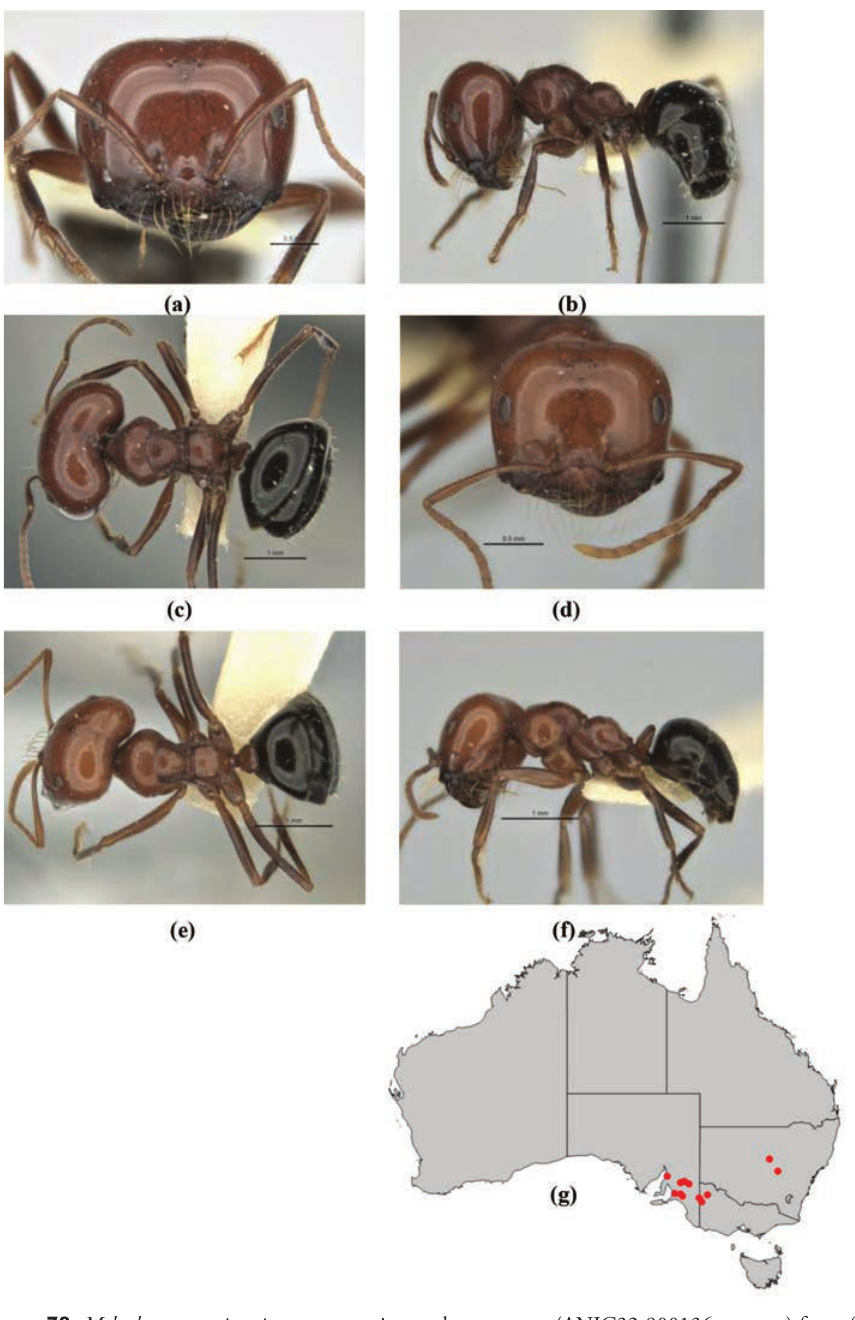
Figure 78. Melophorus cerasinoniger sp. n.: major worker paratype (ANIC32-900136–top ant) frons ( a ), profile ( b ) and dorsum ( c ); minor worker holotype (ANIC32-900136–fifth ant from top) frons ( d ), pro- file ( e ) and dorsum ( f ); distribution map for the species ( g ). Low resolution scale bars: 1 mm ( b, c , e, f ); 0.5 mm ( a, d